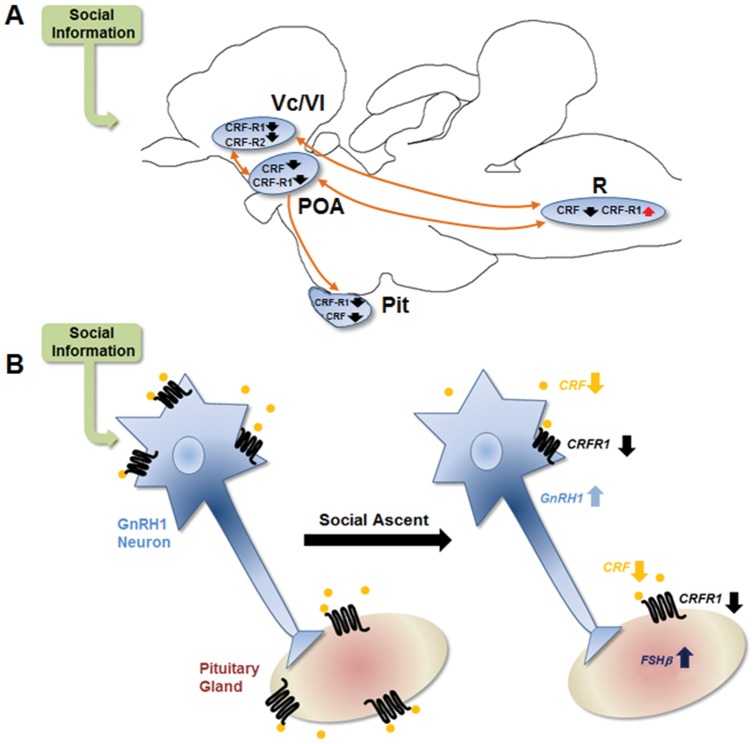
Summary and hypothesized model of the interaction between the stress-related CRF system and reproductive axes during social ascent in male Astatotilapia burtoni.Up and down arrows in both panels indicate higher or lower mRNA levels respectively at 15A) Schematic summary of measured changes in the CRF system during social ascent. Connections between brain regions are indicated with arrows. B) Hypothetical model of the interaction between the CRF-signaling system and GnRH1 neurons in the preoptic area of the brain. At 15 minutes after a subordinate male rises in rank, there are lower mRNA levels of CRF and CRFR1 in the GnRH1-containing POA and pituitary gland. This putative reduced CRF sensitivity in the POA may remove the CRF-induced inhibition on GnRH1 neuron and brain-pituitary-gonadal axis activity, leading to increased reproductive capacity associated with dominant status.